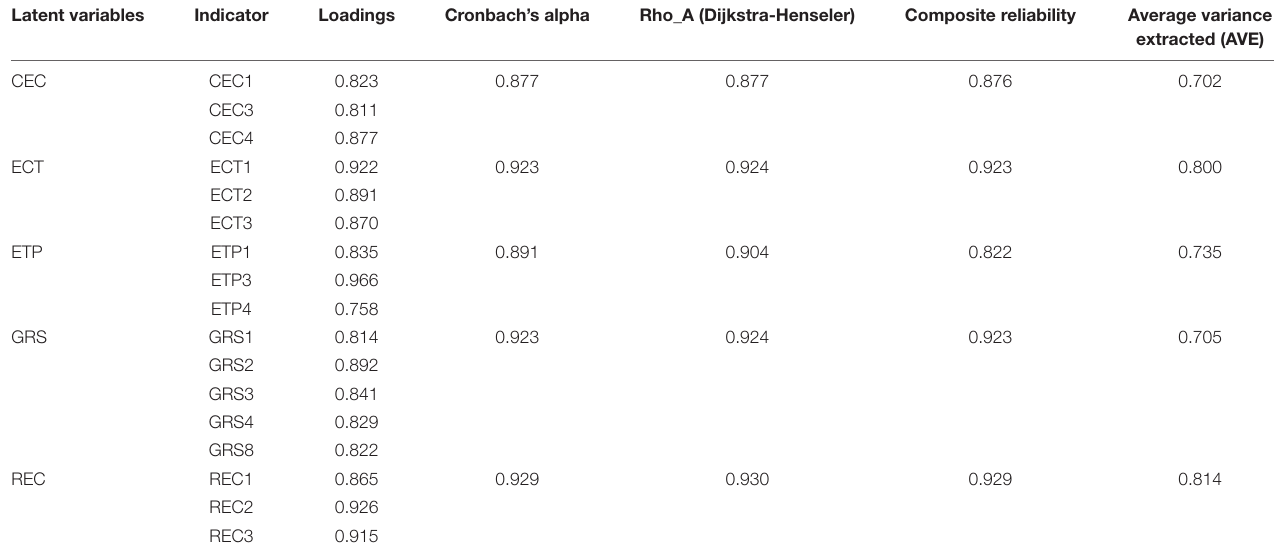
TABLE 3 | Validity and reliability.